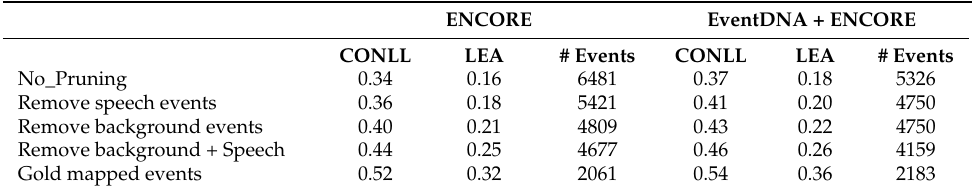
Table 7. Pruning results for the newly trained